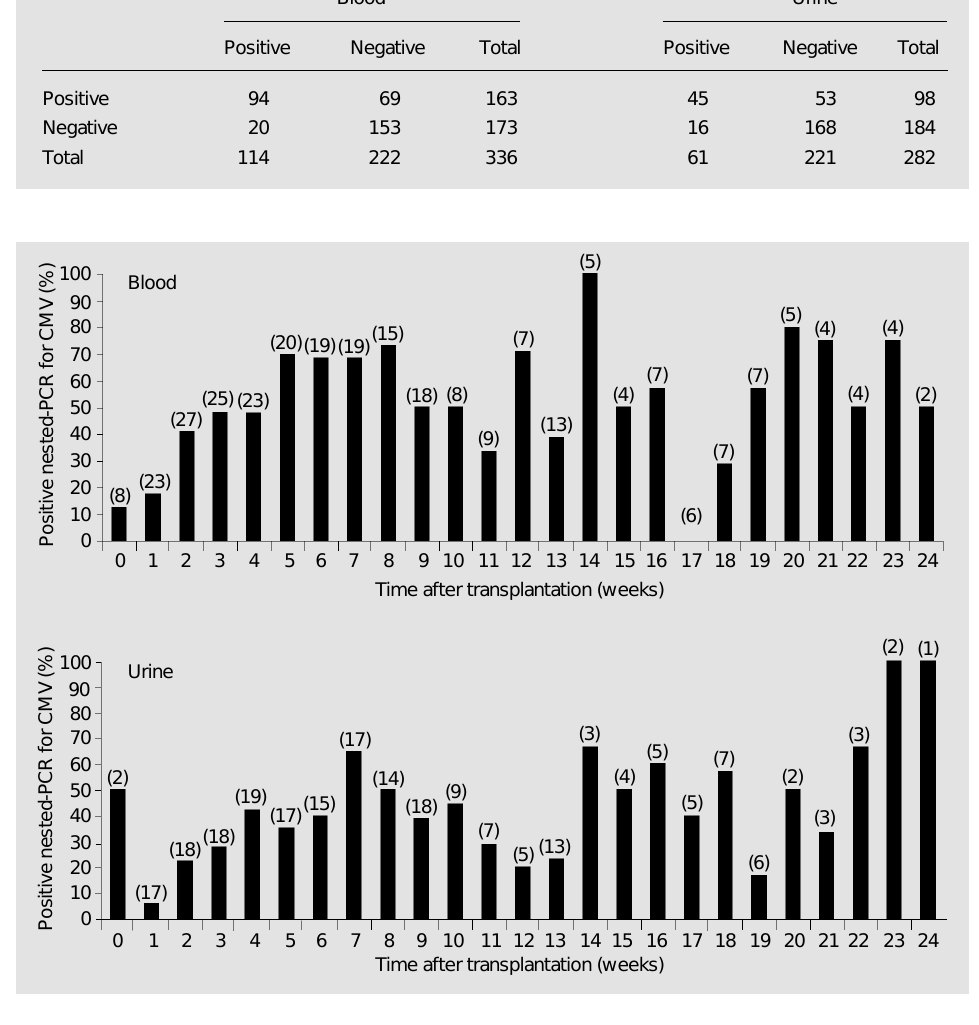
Table 1 - Positive and negative tests for CMV detected in blood and urine samples by nested-PCR using the gB and gH primer sets. Blood